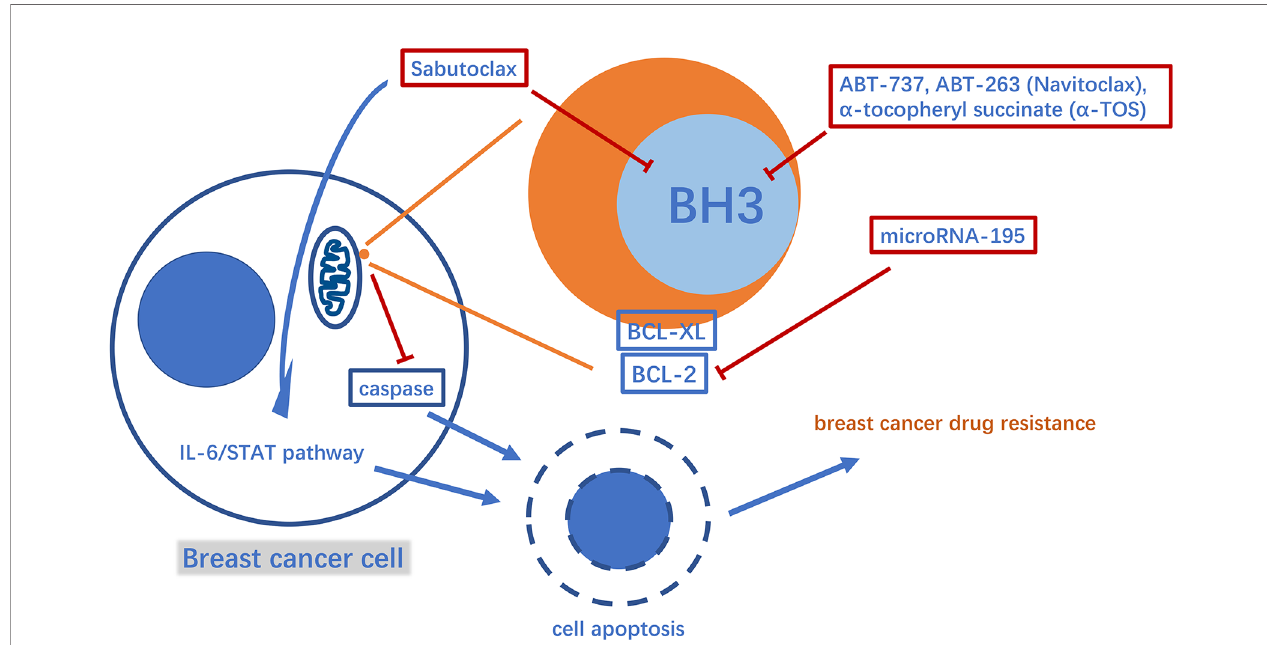
FIGURE 2 | A diagram of some mechanism of mitochondria involved in apoptosis-mediated breast cancer drug resistance and related drugs. BH3, BCL-2 homology domain